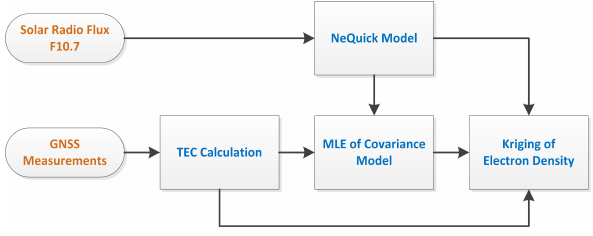
Figure 1. Flow chart of the 3-D simple kriging